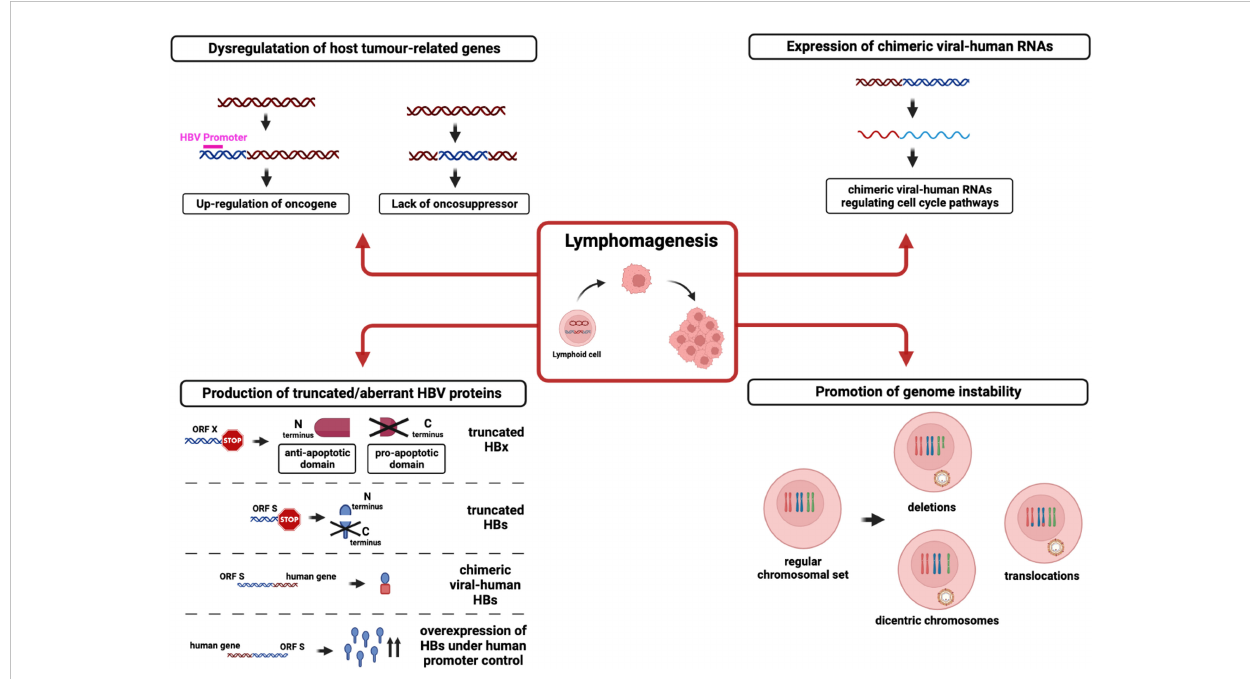
FIGURE 1 Mechanisms involved in lymphomagenesis caused by HBV DNA integration into the host genome. The fi gure shows the potential pathways by which HBV integration in lymphoid cell genome leads to lymphomagenesis: i) HBV DNA (blue) integration into the infected cells ’ genome (red) can alter host tumor-related genes by up-regulating oncogene or by interrupting oncosuppressor activity; ii) HBV integration can generate chimeric viral- human RNAs with a role in regulating cell cycle pathways; iii) integrated HBV DNA can lead to the production of truncated/aberrant HBV proteins, (such as truncated HBx or HBs) as well as chimeric viral-human proteins; iv) HBV integration can promote genomic instability by altering the regular chromosomal